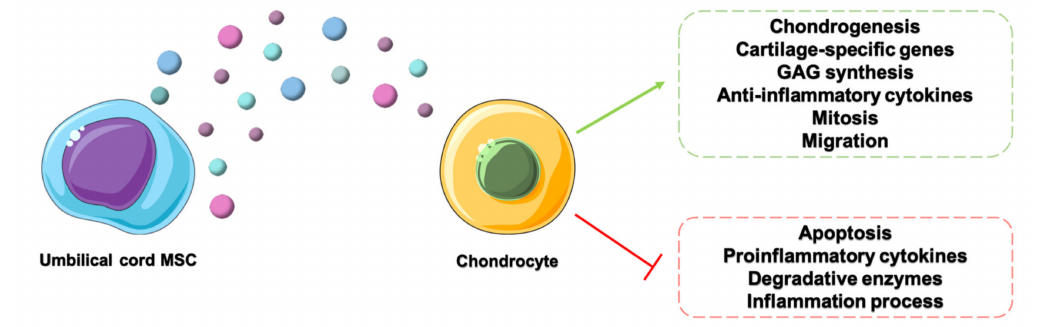
Figure 1. E ff ects of extracellular vesicles (EVs) from umbilical cord mesenchymal stem cells (ucMSCs) on osteoarthritis (OA) chondrocytes evidenced by in vitro studies. GAG: